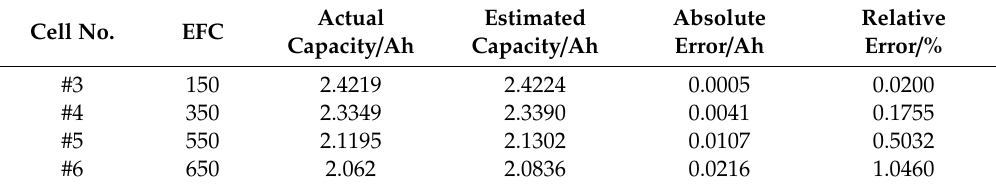
Table7. Estimatedresultsofparameter–fusionestimationmethodat70%SOCunderchargingcondition.